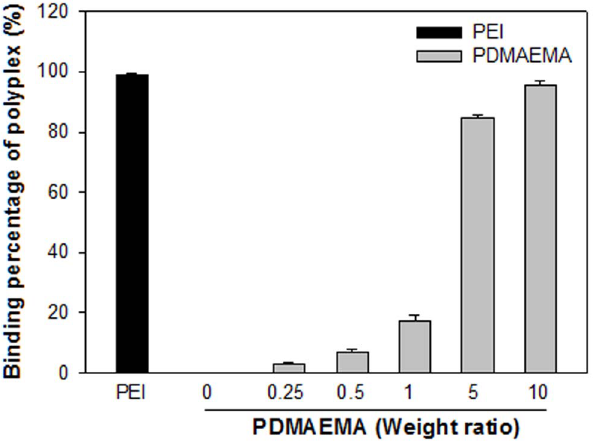
Figure 2. Binding ability of DNA by PDMAEMA at different weight ratios. The binding of DNA saturated at weight ratios of 5 and 10 where no free form DNA remains.